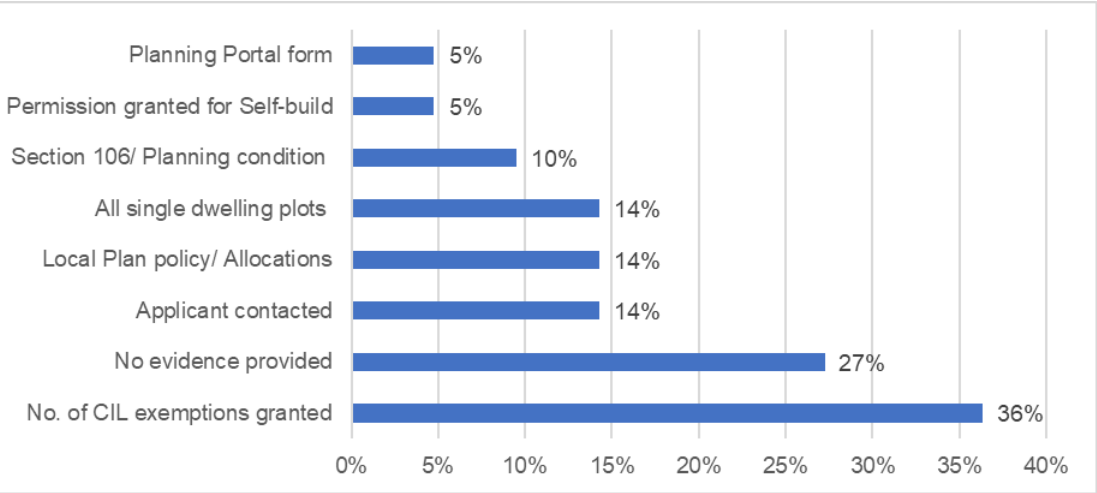
Figure 2. Indicators used to identify suitable development permissions granted. Source: LPA FOI responses.